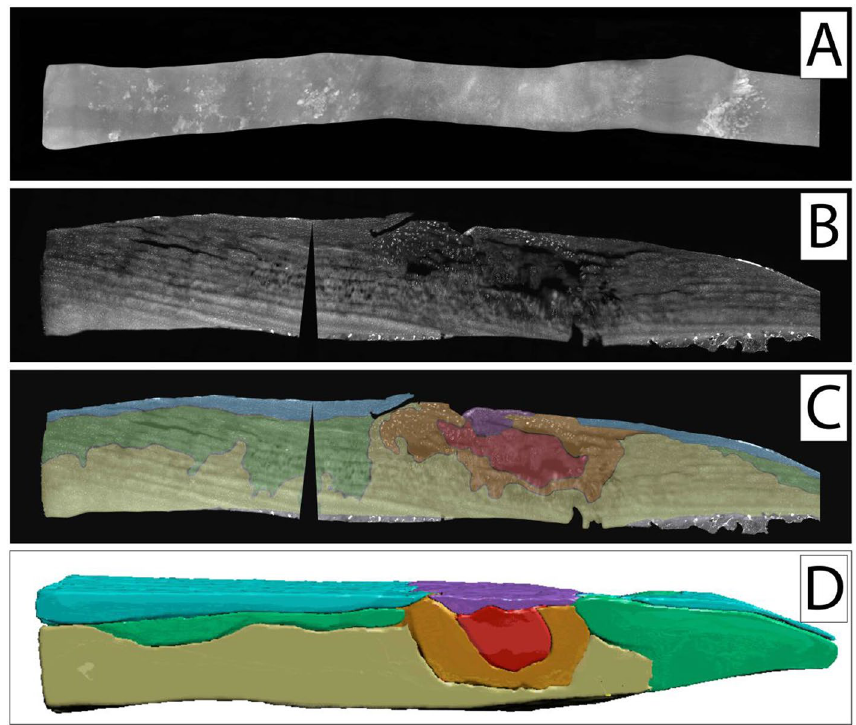
Figure 5. Top-down ( A ) and side view ( B , C ) of cartilage specimen III and the corresponding µCT image rendering ( D ). ( C , D ) Zonal colour labelling of the predominant spatial chondrocyte arrangement: blue— superficial zone, green—single strings, yellow—double strings, orange—small clusters, red—large clusters, purple—diffuse, grey—subchondral bone. The intact cartilage shows the superficial zone, with single strings in the underlying area in the superficially deep zone and double strings deeper down. In the centre is a macroscopic cartilage lesion from the superficial zone to the transitional zone, also partly including the deep zone. The centre of the lesion is composed of large clusters surrounded by small clusters. Around this area, double strings can be found. Single strings are farther away in macroscopically intact cartilage. Interestingly, the superficial centre of the defect is covered with a scar-like plug of densely packed and highly disorganised cells. In the µCT 3D segmentation it can be clearly recognised how the different patterns arrange themselves in their corresponding order in a concentric fashion. The black wedge is a digital artefact of straightening the image. This figure was created using MeVisLab (https:// www. mevis lab. de/ mevis lab), Adobe Photoshop CS6